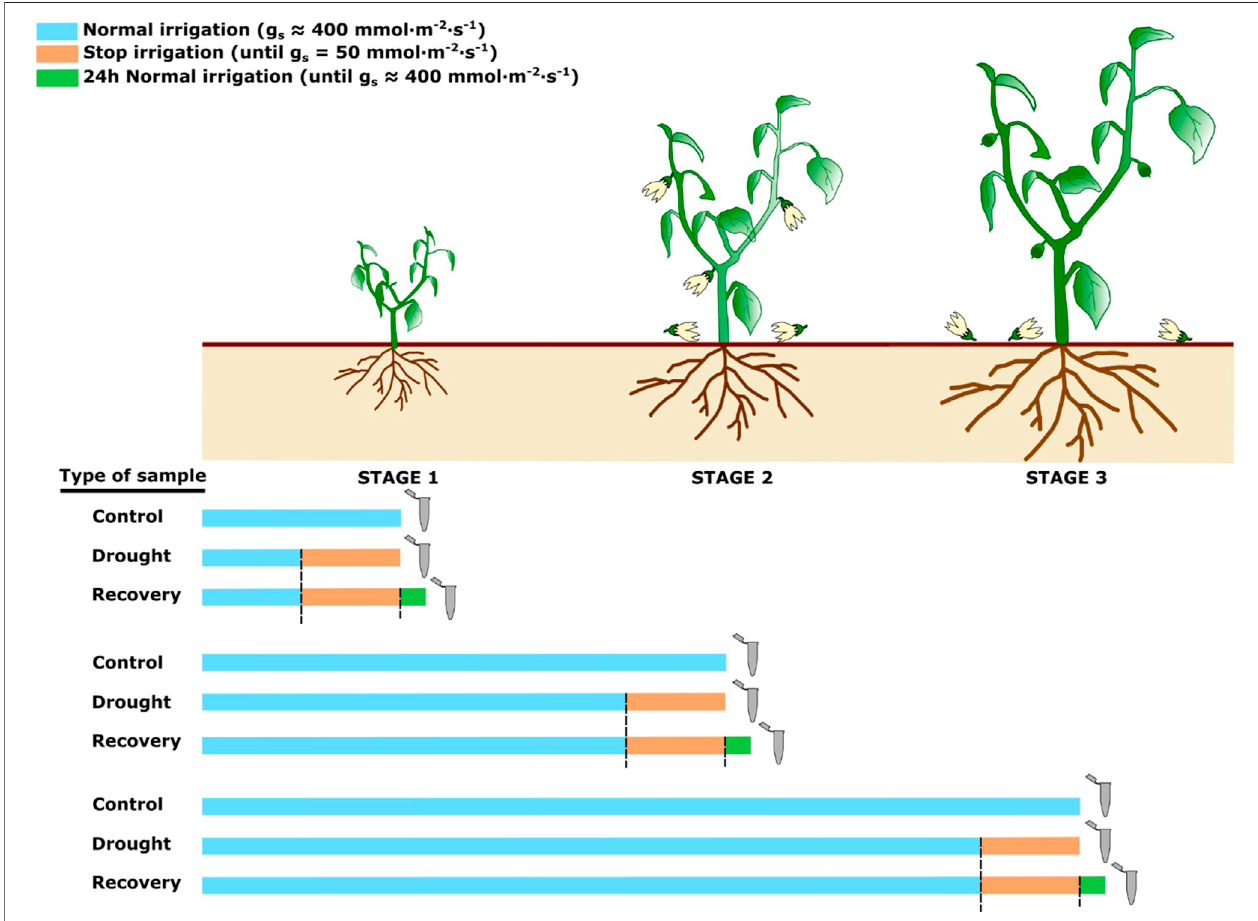
FIGURE 1 | Experimental design of the treatments for control, drought and recovery plants. Grey micro test tubes indicate when the samples were collected. The colour of the bars represents the irrigation status of the plants (light blue (cid:1) normal irrigation; orange (cid:1) no irrigation; green (cid:1) irrigation, 24 h recovery).